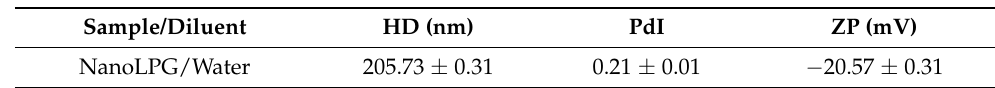
Table 1. Characterization of nanoLPG.